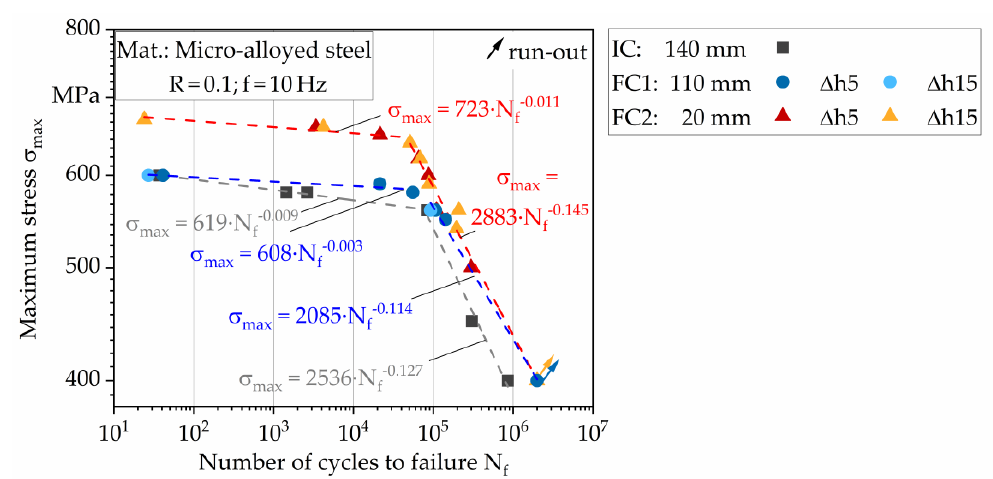
Figure 8. S-N curves for the initial condition and the different hot flat rolled conditions.